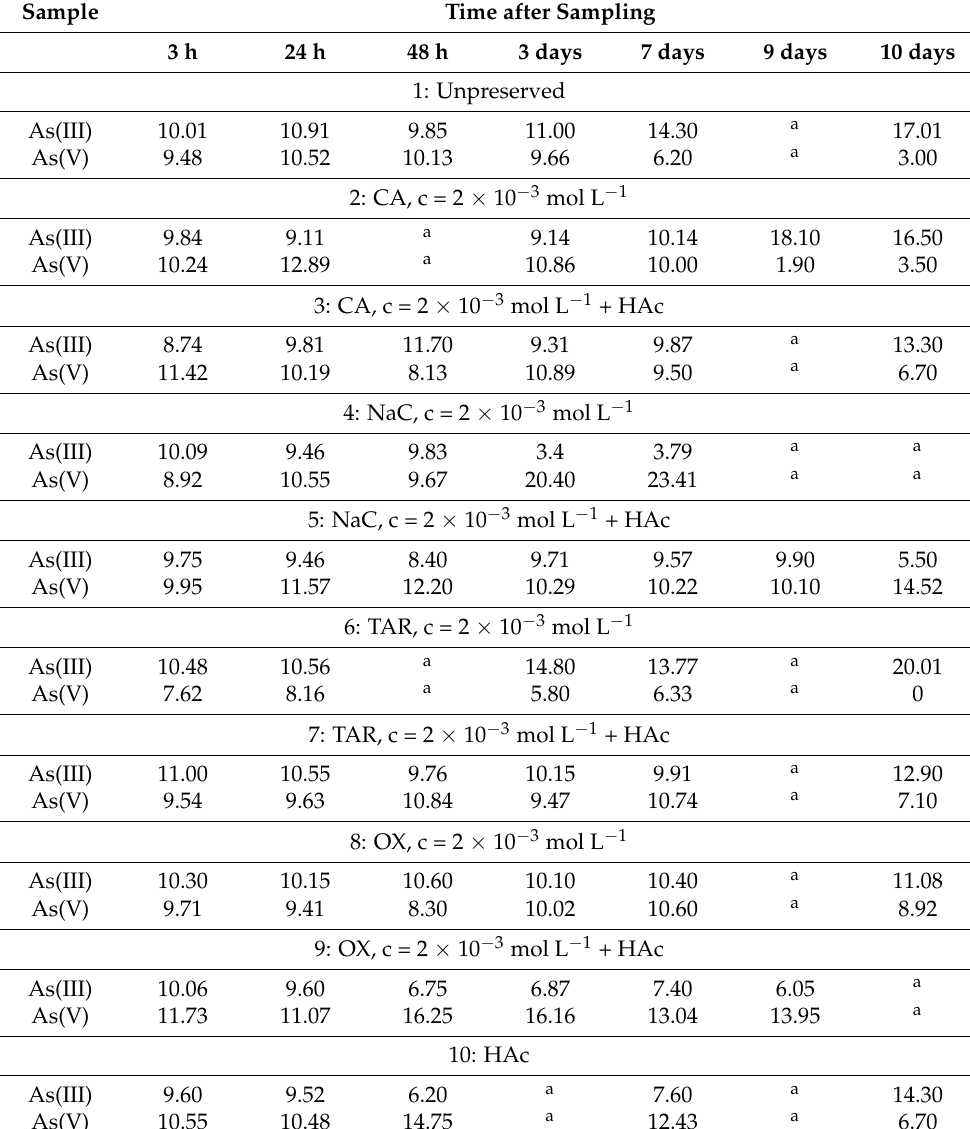
Table 1. Influence of preservation methods on stability of arsenic speciation in As(III)/As(V) 10 µ g L − 1 model